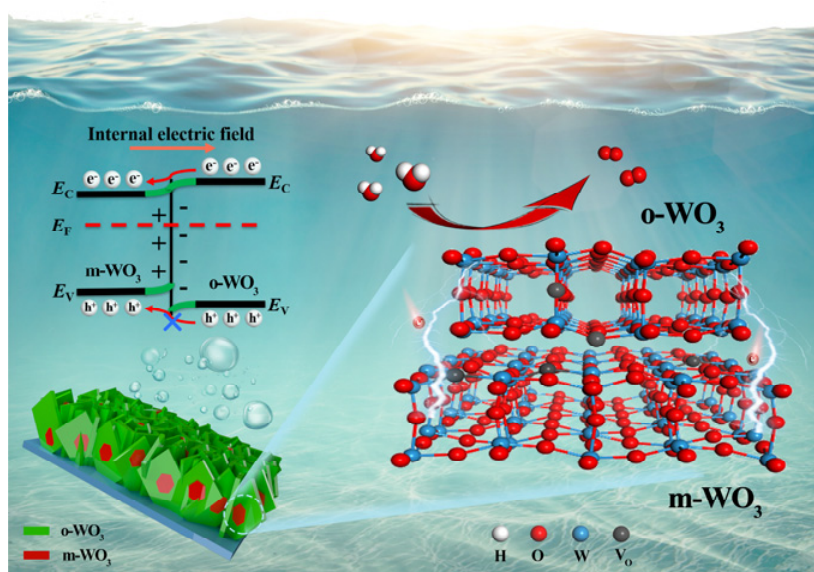
Fig. 9 Diagram of photoelectrocatalytic water splitting on o-WO 3 /m-WO 3 phase